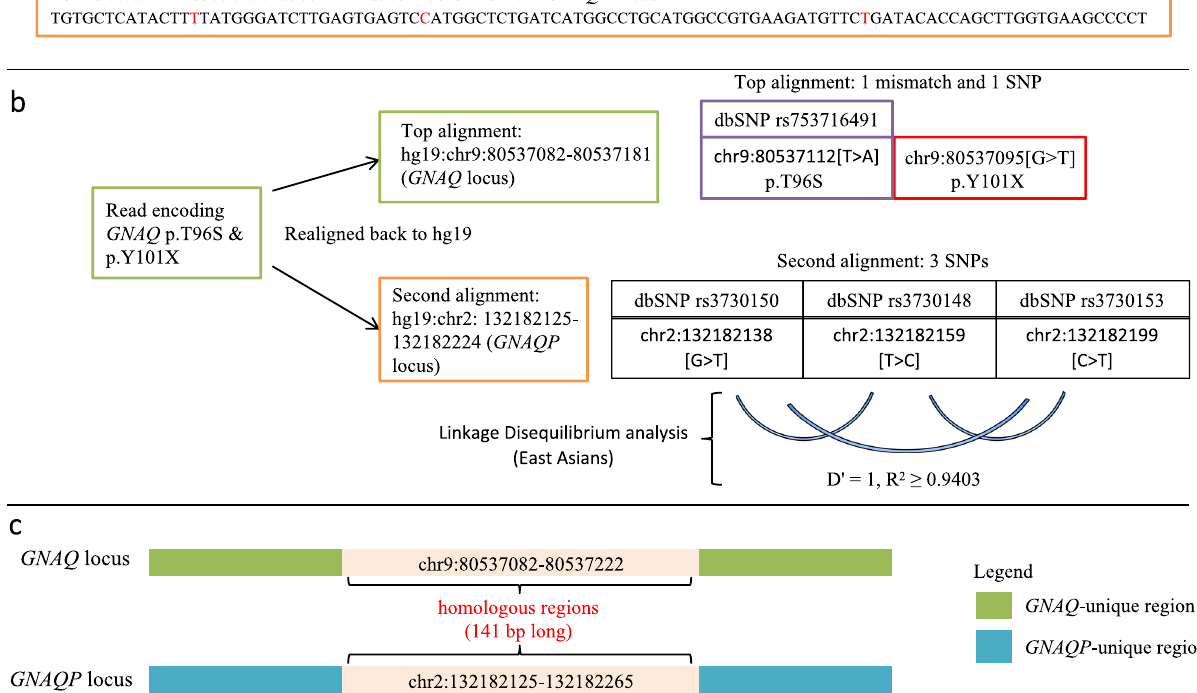
Fig. 1 GNAQ p.T96S and p.Y101X mutations could be the results of misaligned sequencing reads from GNAQ-Pseudogene-1. a Reference sequence from GNAQ locus (top), in silico simulated read that would encode for GNAQ p.T96S and p.101X mutations (middle — green box) and in silico read that represents co-occurring SNPs, rs3730150, rs3730148 and rs3730153 (bottom — orange box; the co-occurring SNPs are in red). b Top-scoring alignments of the read that would encode for GNAQ p.T96S and p.101X. The read aligns to both GNAQ (with one mismatch and one SNP) and GNAQP (with three SNPs) simultaneously. Linkage disequilibrium analysis of the three SNPs from the GNAQP locus also showed that they tend to co-occur and cause an misalignment to GNAQ locus. This misalignment would yield the wrong callings of GNAQ p.T96S and p.101X mutations. c GNAQ - GNAQP homologous regions that implicated p.T96S and p.Y101X, and rs3730150, rs3730148 and rs3730153 in the GNAQ and GNAQP loci, respectively. The immediate regions outside of chr9:80537082-80537173 are unique to GNAQ that would further help Zhaoming Li et al. to further validate their current fi